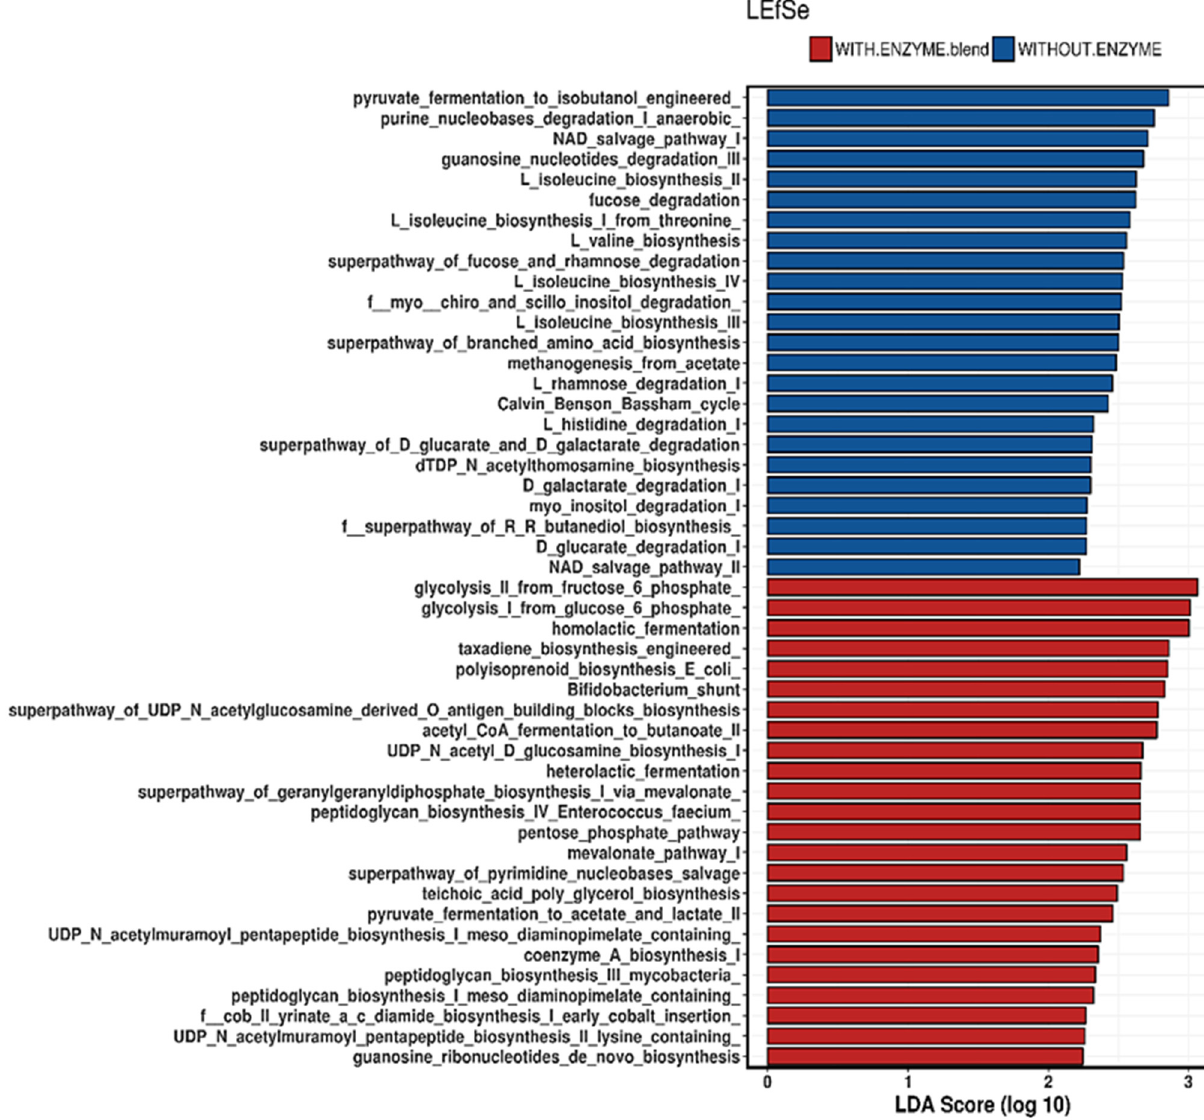
Figure 3. Predicted functions of the cecal microbiota of broilers at 21 d of age fed diets with or without inclusion of an enzymatic blend, identified by linear discriminant analysis (LDA) coupled with effect size (LEfSe) using default parameters.